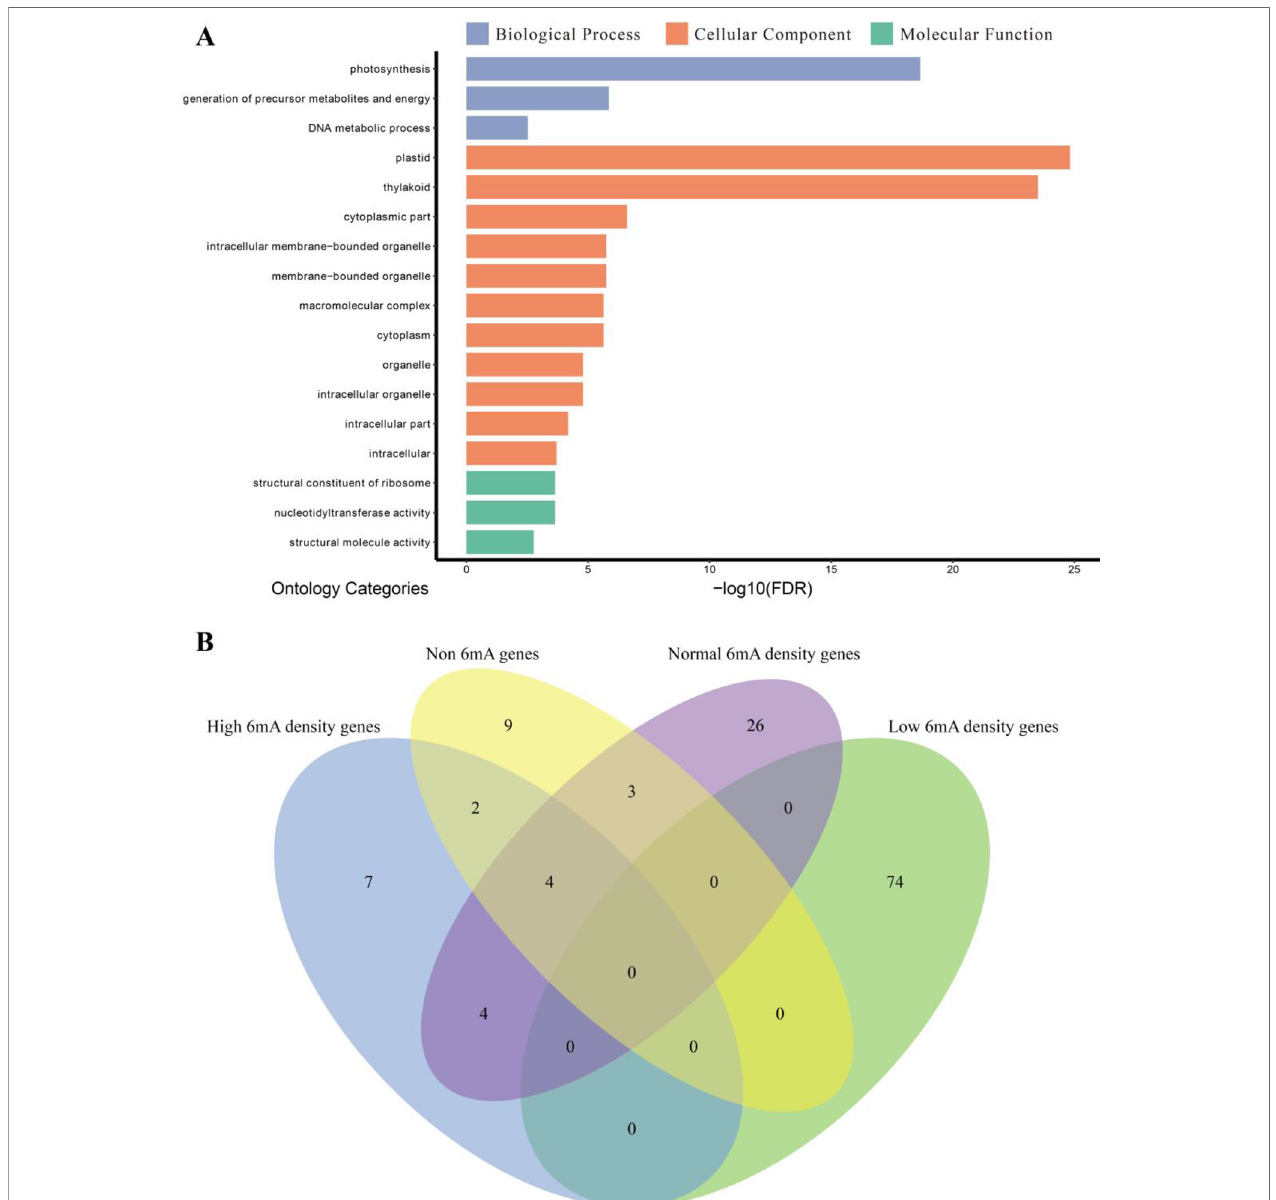
FIGURE 6 | Gene ontology (GO) enrichment analysis. (A) GO enrichment categories of high-methylation-density protein-coding genes ( n = 993) in Fragaria vesca . The GO categories are listed with the false discovery rate-adjusted P value <0.01. (B) Venn diagram of enrichment categories of four gene